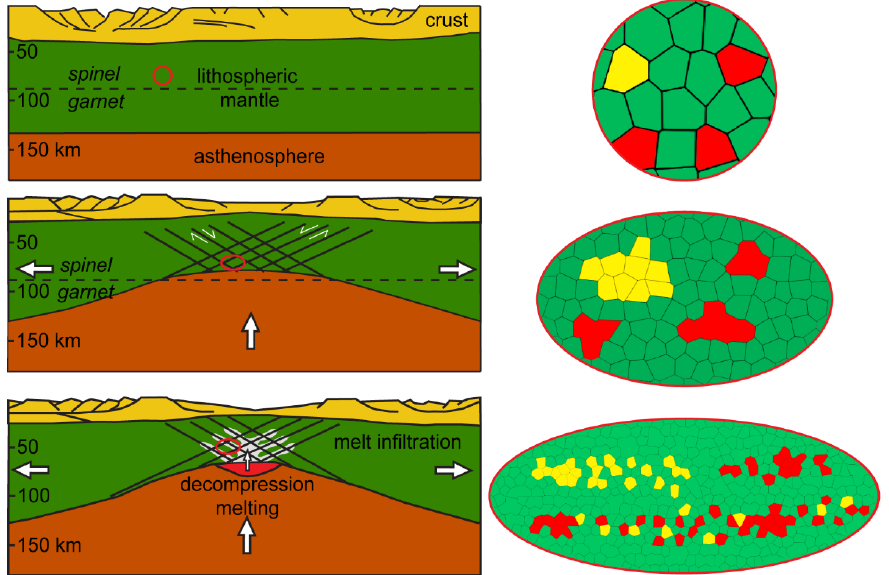
Figure 13. Sketches of the rifting (modified after [61]) in the left panels, and the corresponding microstructural evolution in the spinel shear zones of the Erro-Tobbio peridotite (locations indicated with the red circle and ellipses) in the right panel. The white arrows indicate the movement directions of the lithosphere and asthenosphere. The microstructures show the evolution from the undeformed peridotite with large grains of olivine (green), opx (red) and cpx (yellow). During the first stage of thinning, cpx and olivine recrystallize, whereas opx porphyroclasts elongate or remain equigranular. During ongoing thinning melt infiltrates, reacts with the dynamically recrystallized cpx grains and opx porphyroclasts, forming cpx+ol fine-grained layers and opx + ol + cpx fine-grained layers.